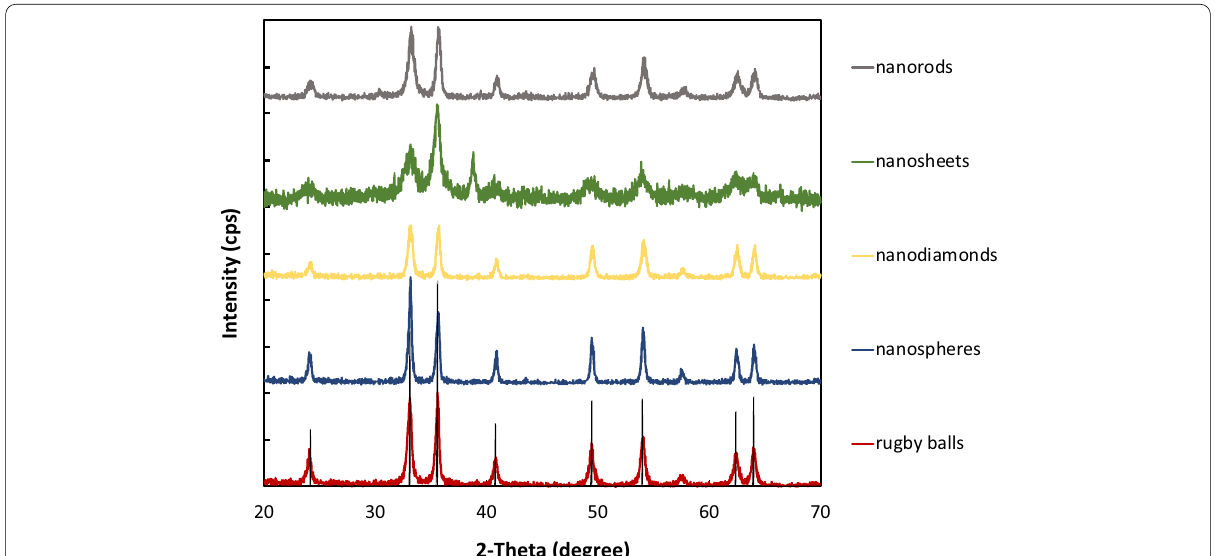
Fig. 1 XRD spectra for the hematite nanorods (Grey), nanosheets (Green), nanodiamonds (Yellow), nanospheres (Blue), and rugby balls (Red) shaped